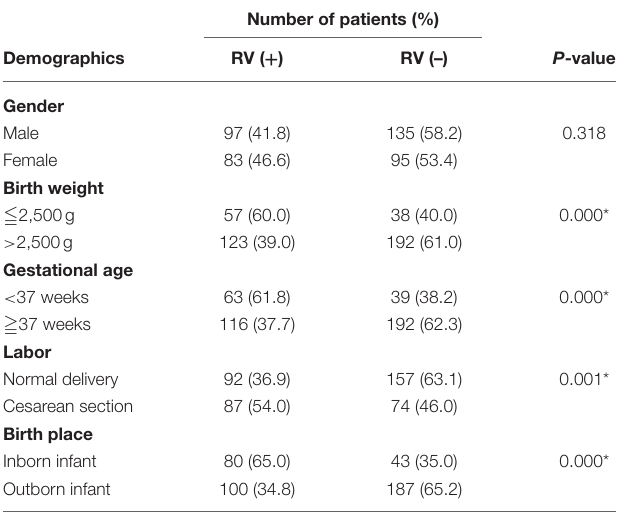
TABLE 1 | Demographic characteristics of rotavirus positive cases and negative cases in NICU.